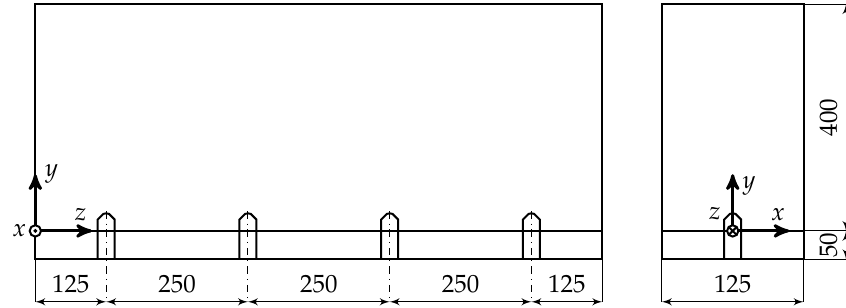
Figure 4. Dimensions of the simulation domain of the GF25 pilot-scale plant in mm.